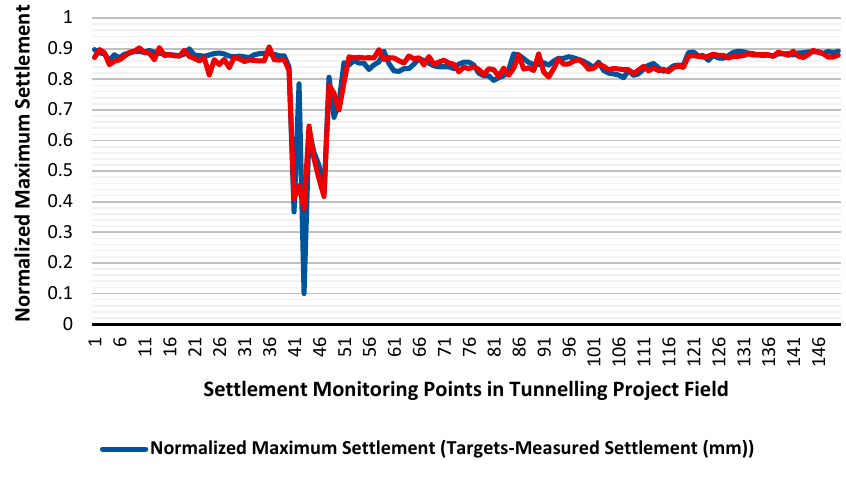
Figure 10. The comparison of predicted settlement results (mm) with measured settlement data